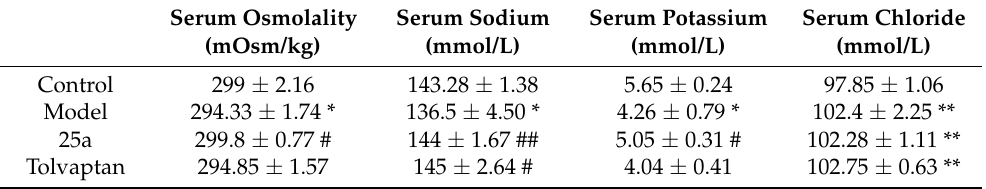
Table 1. Serum osmolality and electrolyte concentrations in